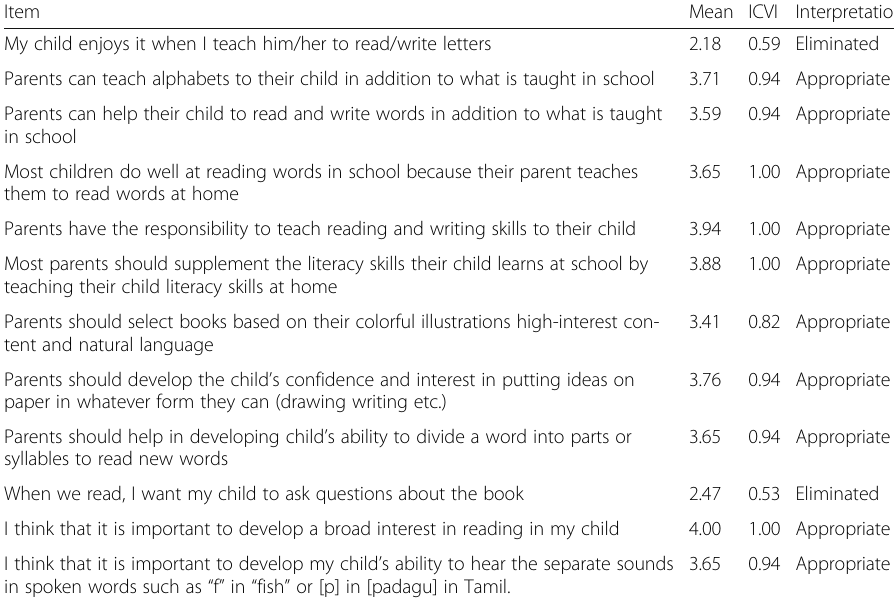
Table 5 Item Level Content Validity Index (ICVI) for the dimension “ Parental beliefs ” (PB) Item